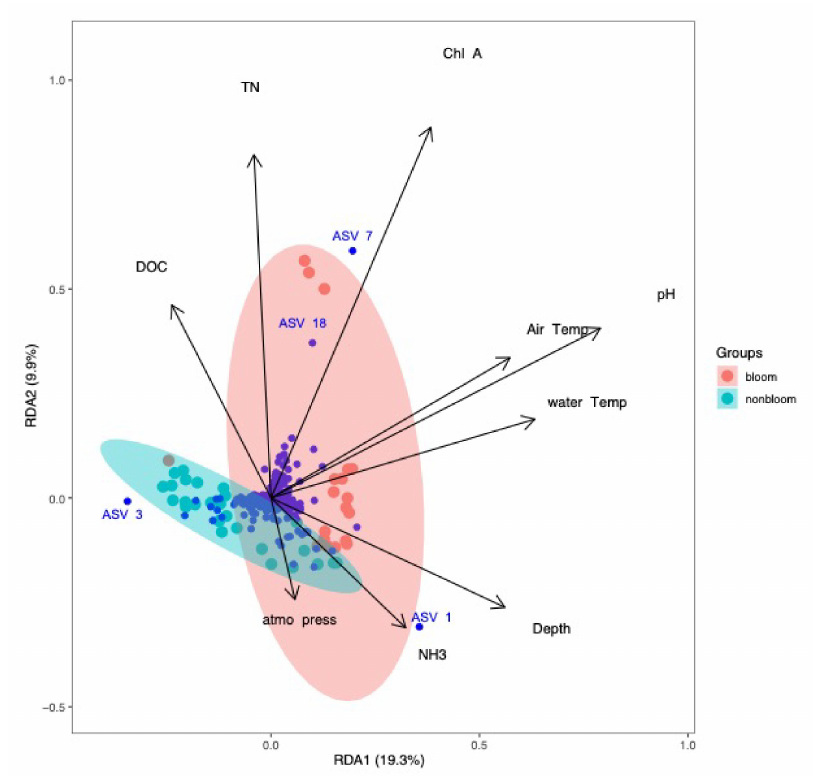
Figure 10. Redundancy analysis of bacterial community and environmental parameters for samples collected in 2018. NH 3 had a positive correlation with the non-bloom bacterial community. The bloom samples were strongly associated with TN, DOC, chlorophyll-a, pH and